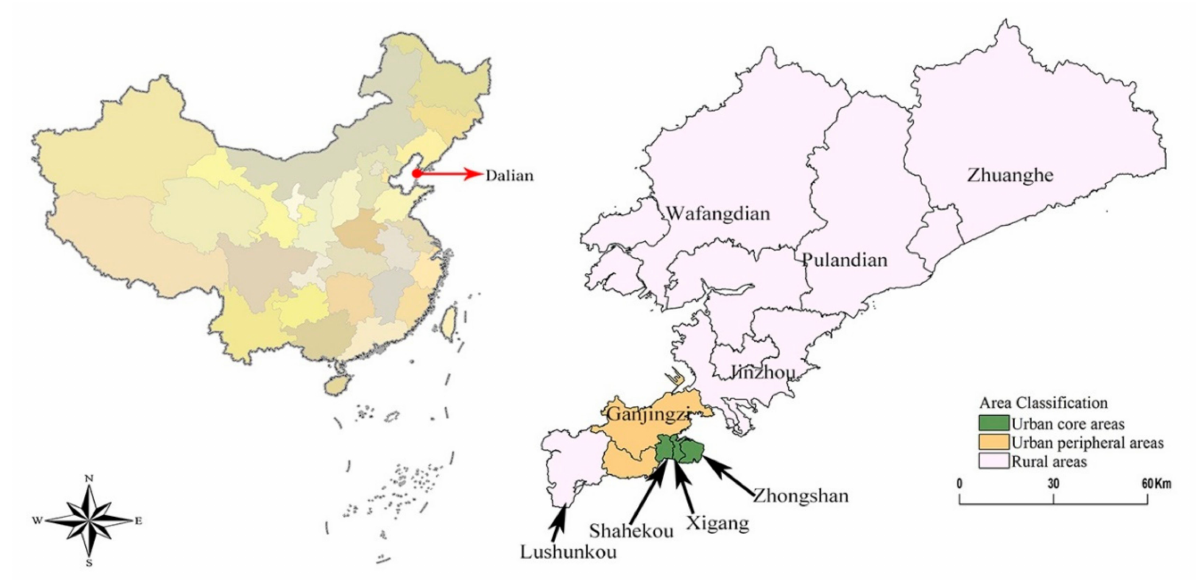
Figure 1. Overview of Dalian City.